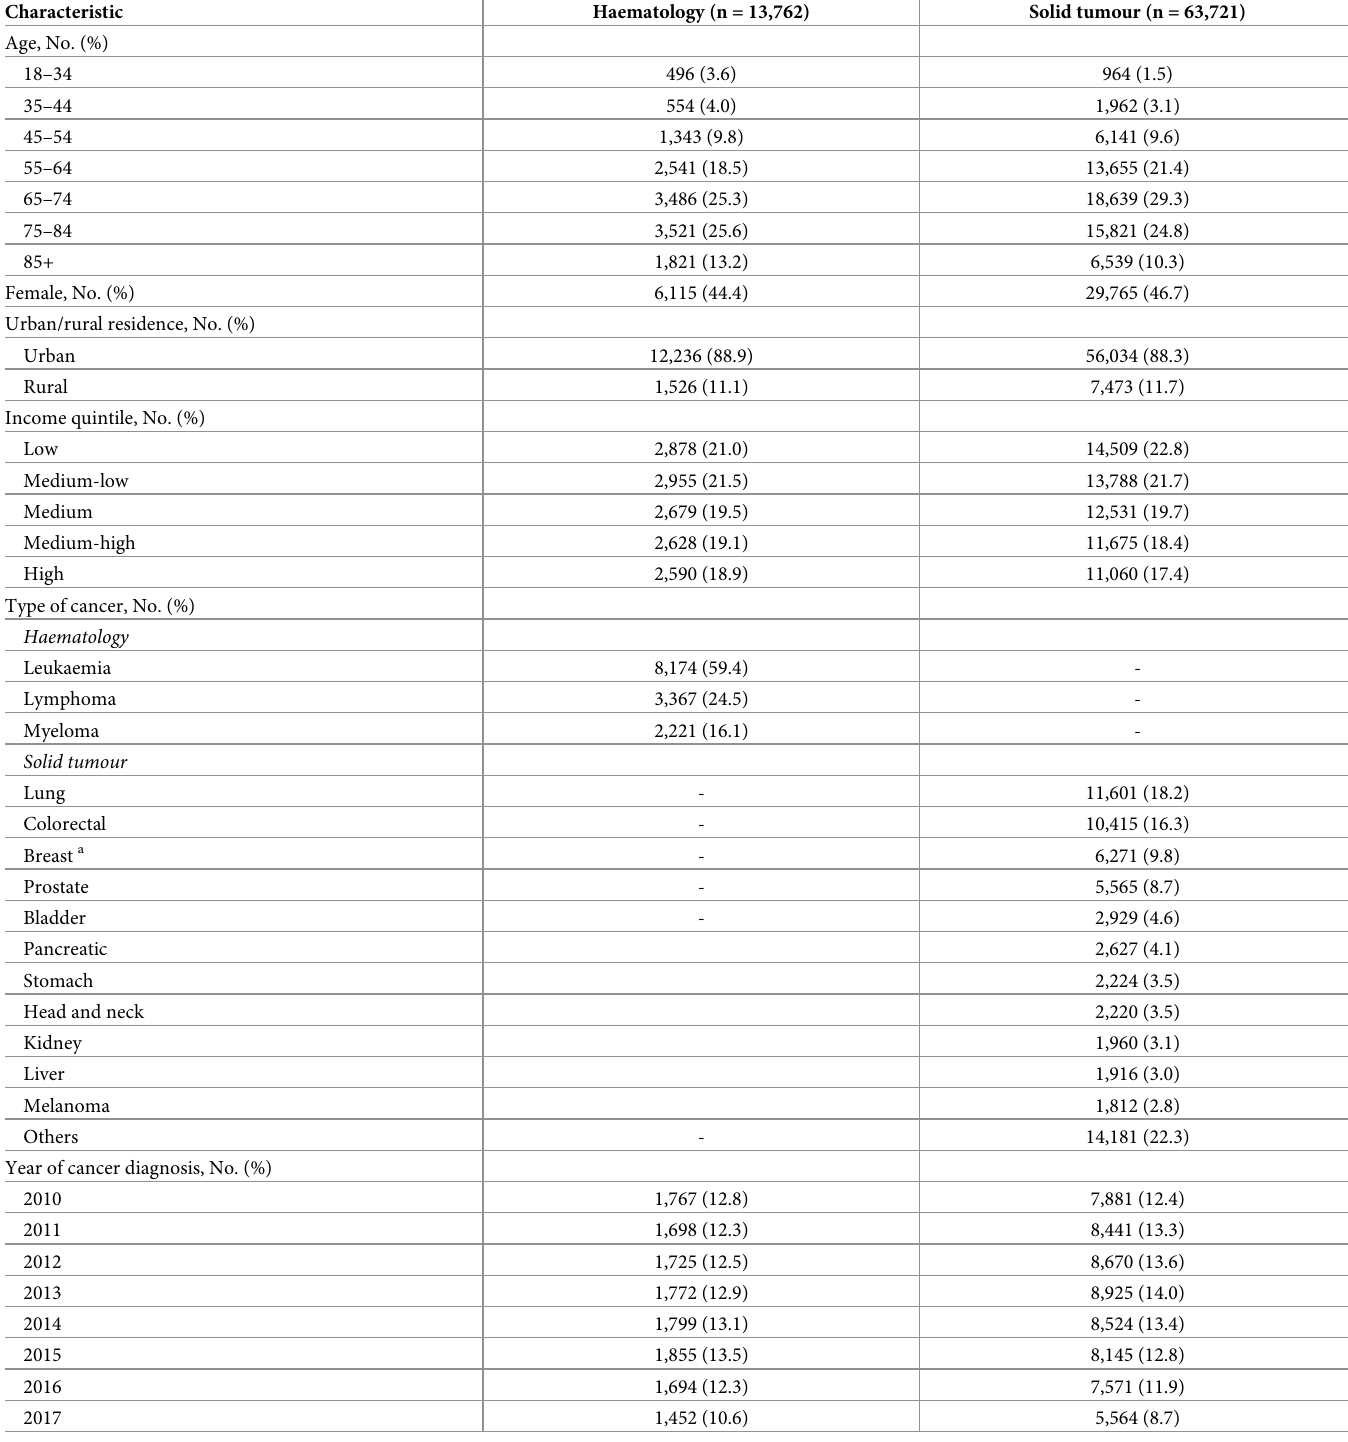
Table 1. Characteristics of cancer patients with sepsis by malignancy